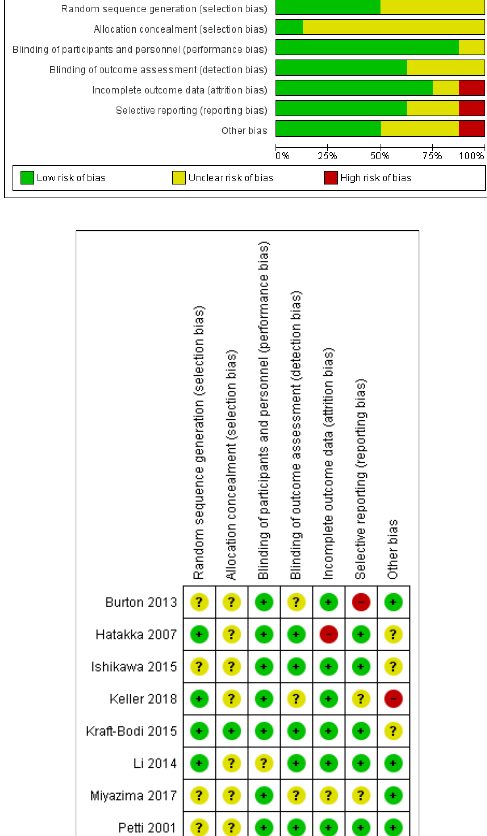
Figure 2. Risk of bias summary and graph. Green: low risk, yellow: unclear risk, red: high risk. In total, 50% of RCTs appropriately described the random sequence generation process, but only one